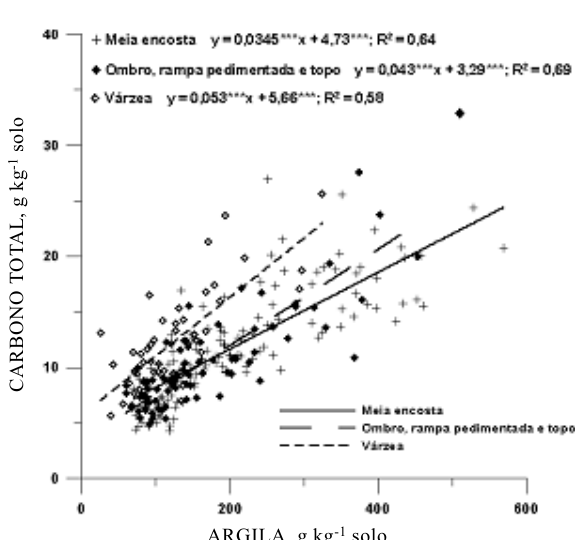
Figura 2. Relação entre C total e argila de acordo com as posições no